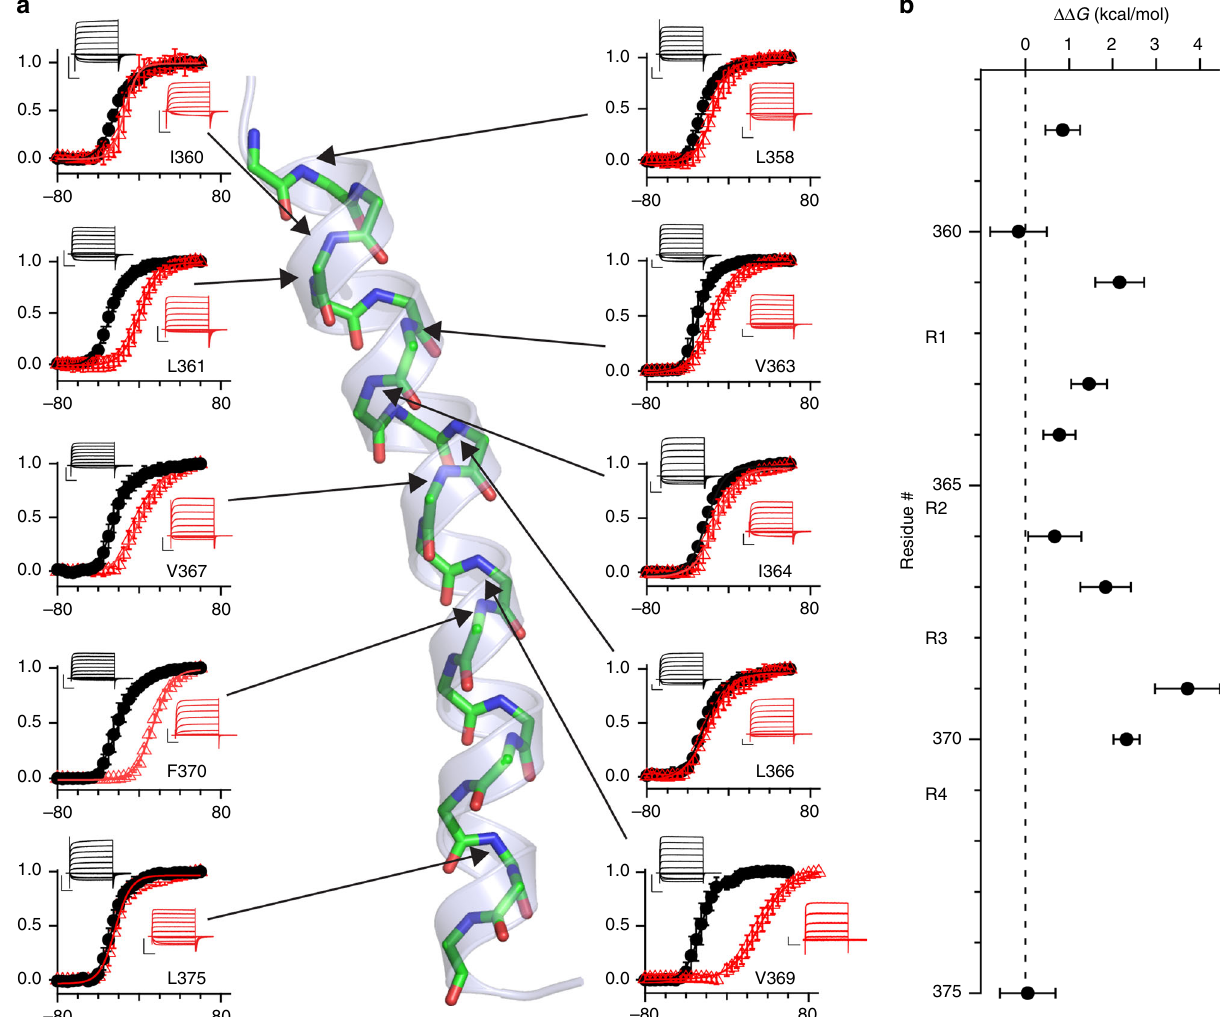
Fig. 3 Functional nonequivalence of ester substitutions in the S4 segment. a Conductance – voltage ( G – V ) relationships for amino (WT, black) and hydroxyl acids (red) encoded at the indicated sites in S4. Solid lines represent Boltzmann fi ts to the data obtained with 5 mV steps. Insets show representative potassium current traces elicited with depolarizations from − 80mV to + 60 mV in 10 mV steps. Full-size currents and pdCpA-negative control traces can be found in Supplementary Figure 2. Scale bars equal 5 μ A and 50 ms for current size and duration, respectively. b Free energy change on channel gating by site. All data shown in a , b are mean ± standard deviation from 3 to 13 oocytes. Data were repeated from at least two separate batches of cRNA and